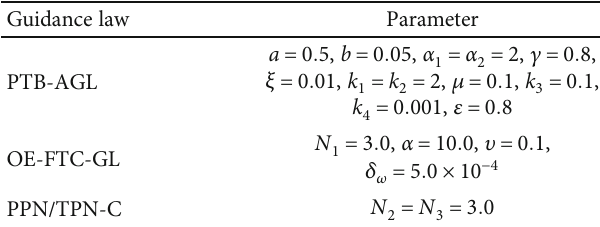
Table 2: Initial state of missile and target. Table 3: Parameter settings for guidance